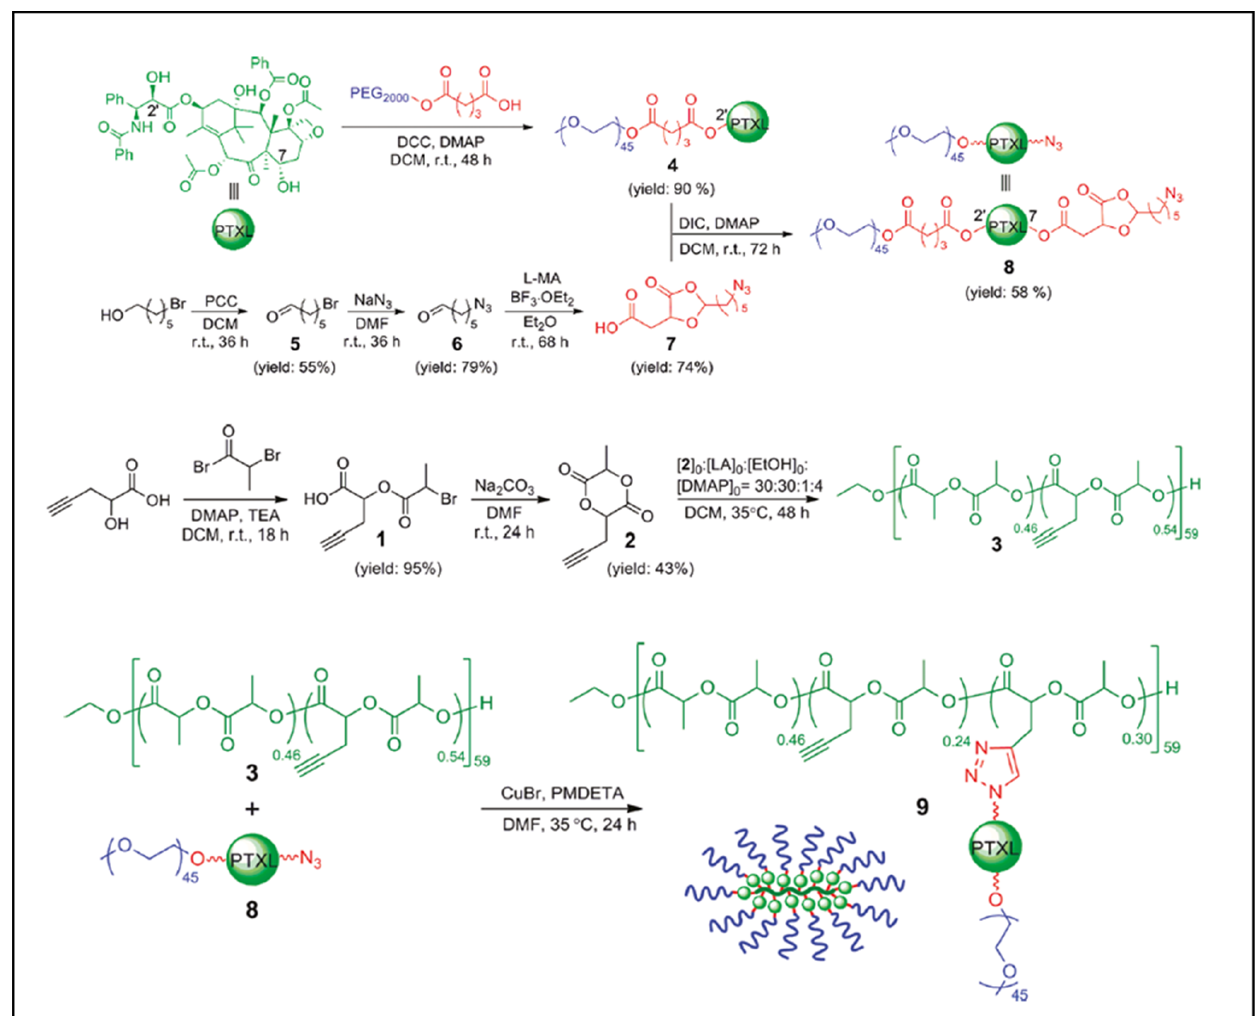
Figure 2. Reaction scheme for the synthesis of PLA- g -Paclitaxel-PEG (adapted from Yu et al.